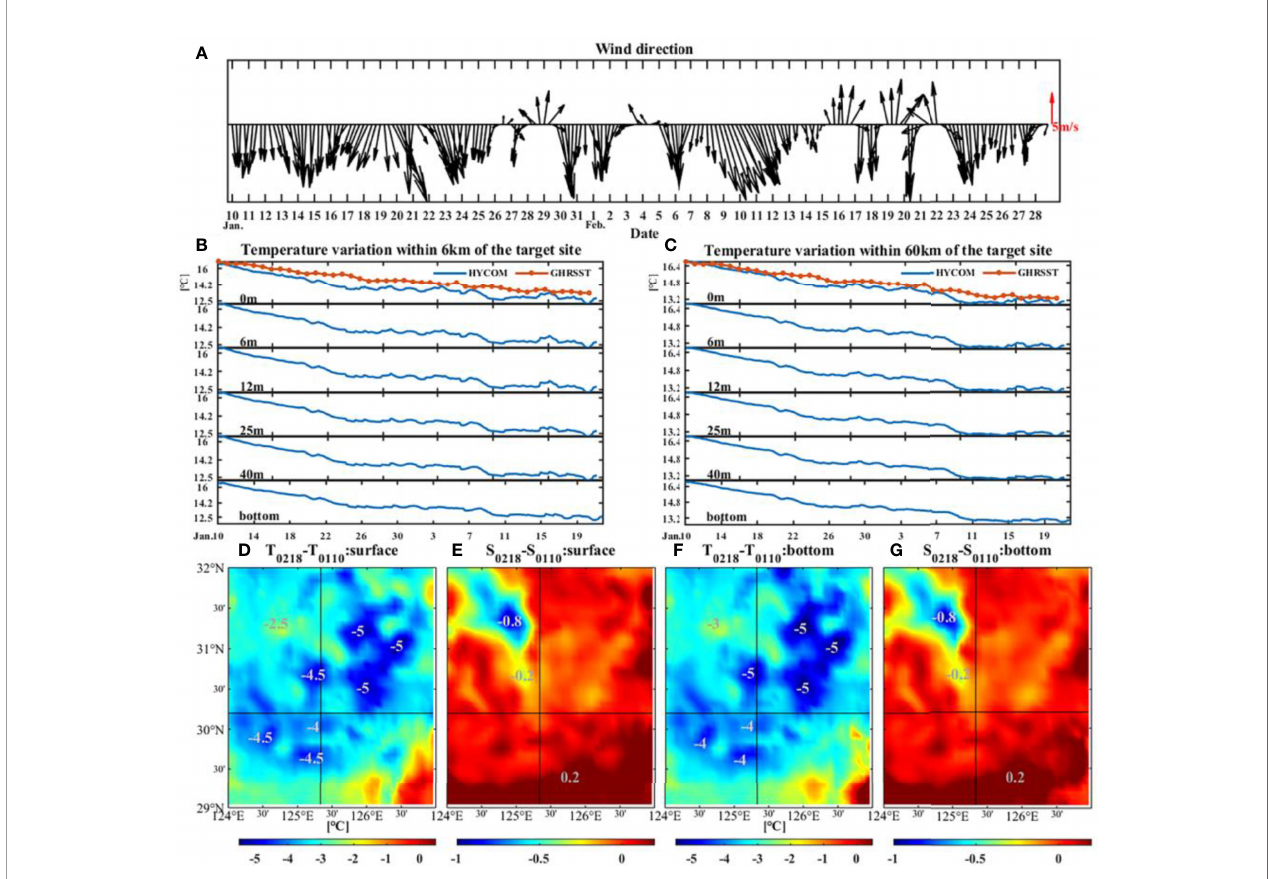
FIGURE 6 | Changes of wind direction at the target site from 10 January 2017 (A) . The data were from CCMP. Sea temperature variation from surface to bottom within 6 km (B) and 60 km (C) of the target site. The differences of surface (D) and bottom (F) temperatures and the differences of surface (E) and bottom (G) salinities between 18 February and 10 January 2017. The areas of decline have been marked. The temperature and salinity data were from